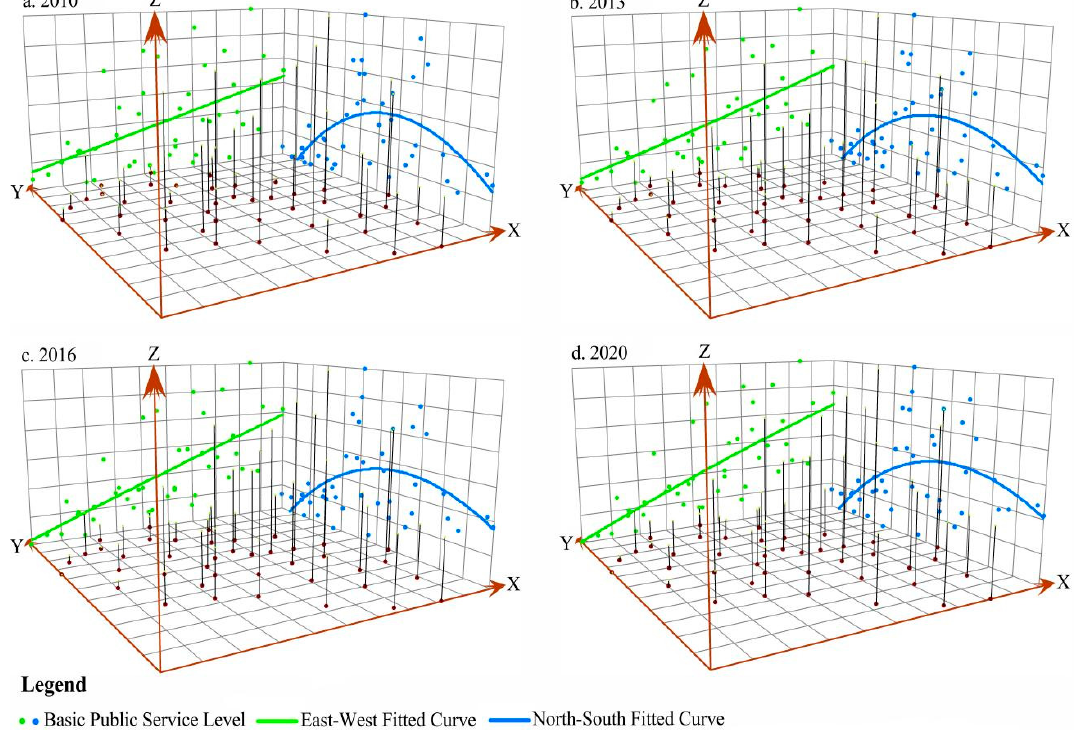
Figure 5. Spatial trend surface of basic public service levels in the YRDR, 2010–2020.